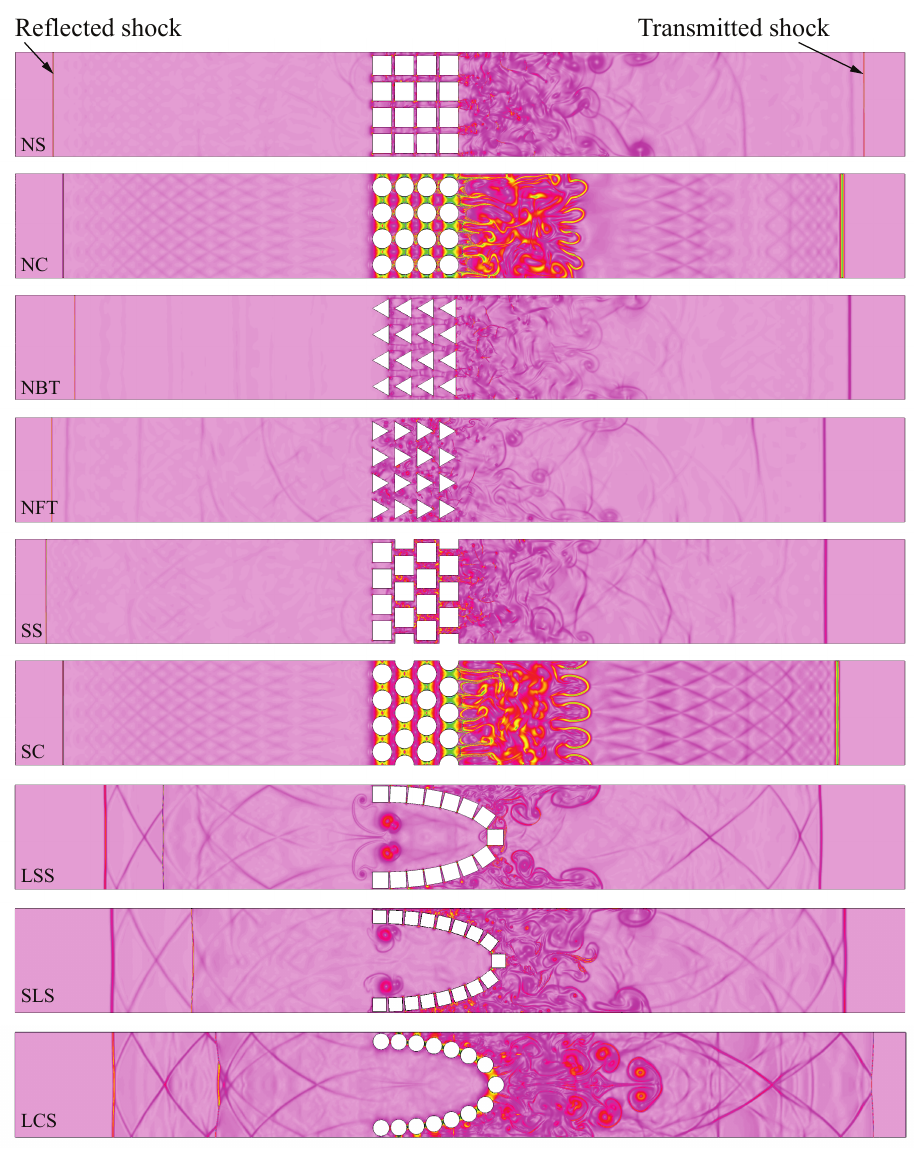
Figure 6. Top to bottom: NS, NC, NBT, NFT, SS, SC, LSS, SLS and LCS schlieren contours taken at t = 500 µ s after the shock first impacts the obstacle array. The locations of the incident shock wave and the reflected shock wave are marked with arrows. Note: the first six cases, from top to bottom, are reproduced from